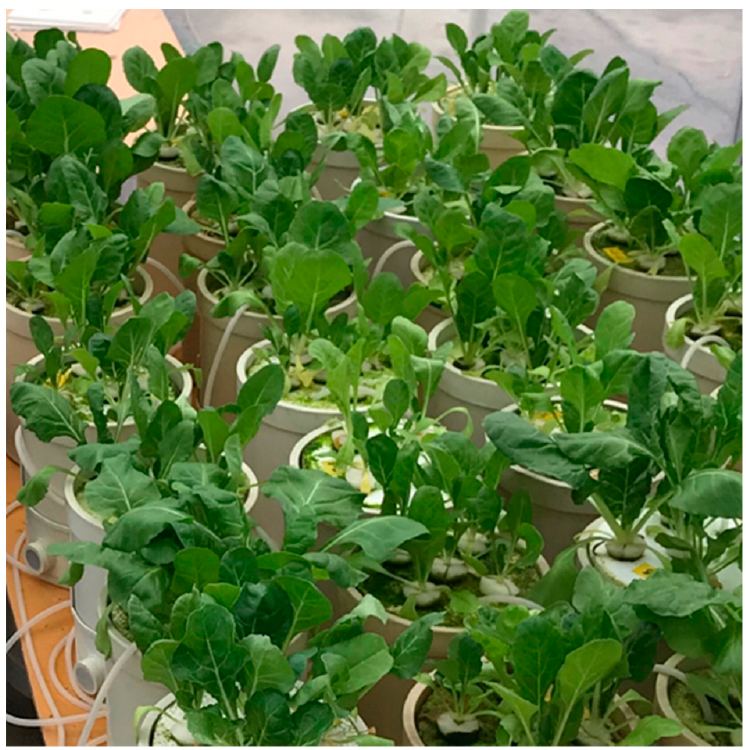
Figure 2. The hydroponic cultivation experiment used in this study.